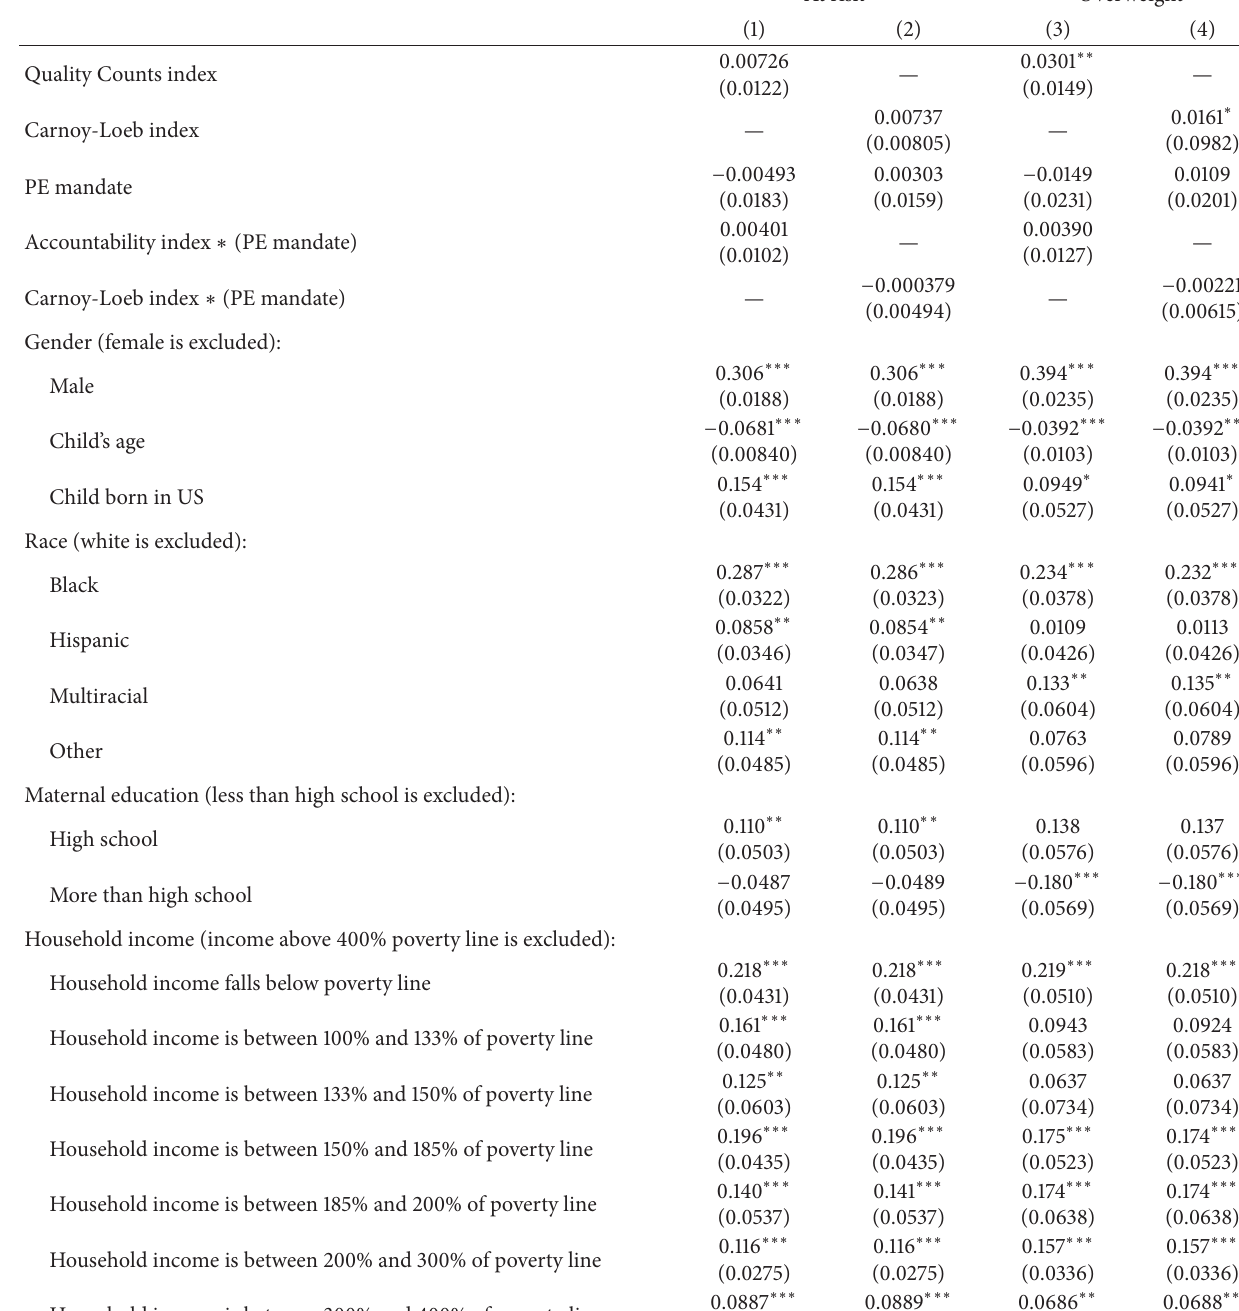
Table 5: Empirical results: effect of accountability pressures on overweight levels, high